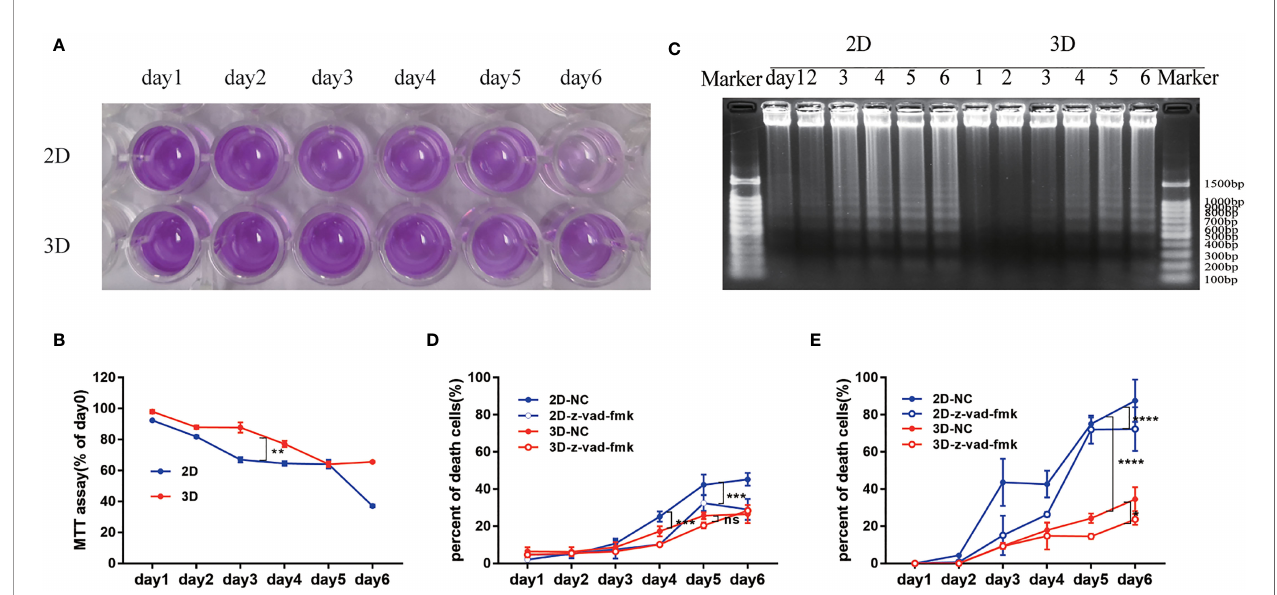
FIGURE 4 | TheactivityofNeuin2Dand3Dculturesystems. (A) SurvivalratewasevaluatedbytheMTTassay. (B) Percentageoftheabsorbancevaluerelativetothecellsonday 1wasusedtoindicatetheactivecells. (C) DNAintegritywasdeterminedbyelectrophoresisofDNAisolatedfromculturedmouseNeufor1-6days.Eachslotwasloadedwith50 m g ofgenomicDNA(correspondingto5x10 5 Neuusedforpreparation).PercentageofPIpositiveinthetotalmouse (D) andhuman (E) peripheralbloodNeuwhichweredyedby SYTO13during6daysin2Dand3Dculturesystemswithorwithouttheinhibitionofapoptosisz-vad-fmkwasusedtoindicatethedeadcells.Datafromoneofthreeexperiments performedareshown.Errorbarsrepresentmean±S.D.n=3,*p<0.05,**p<0.01,***p<0.001,****p<0.0001,ns,notstatisticallysigni fi